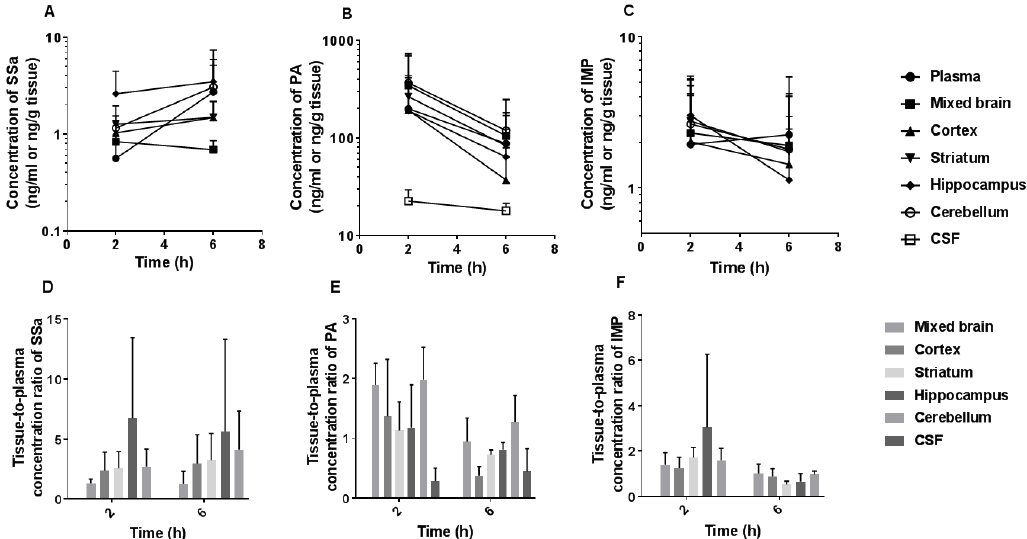
Figure 7. Mean plasma and brain regional concentration–time profiles of ( A ) SSa, ( B ) PA, and ( C ) IMP and their tissue-to-plasma (T/P) concentration ratios ( D , E , and F for SSa, PA, and IMP, respectively) following multiple oral administration of DA-9805 (250 mg/kg/day for 8 days) at 2 h ( n = 5) and 6 h ( n = 4) after the final dose. Vertical bars represent SD.